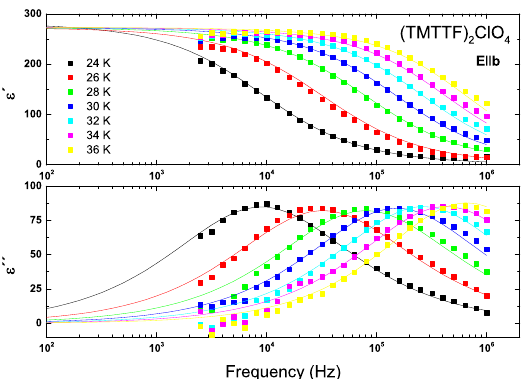
Figure 19. Frequency dependence of the permittivity ˆ (cid:101) ( ω ) = (cid:101) (cid:48) ( ω ) − i (cid:101) (cid:48)(cid:48) ( ω ) of (TMTTF) 2 ClO 4 measured with E (cid:107) b (cid:48) at various temperatures close to the AO transition. The real part (cid:101) (cid:48) ( ω ) exhibits a roll-off that shifts to higher frequencies with increasing temperature. This behavior corresponds to a peak in (cid:101) (cid:48)(cid:48) ( ω ) as shown in the lower panel. The solid lines represent fits according to the generalized Debye model (1).